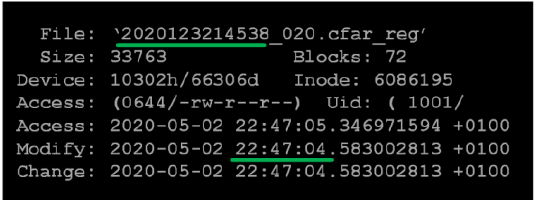
Figure 5. Log file showing the times relevant for cfar_reg files.